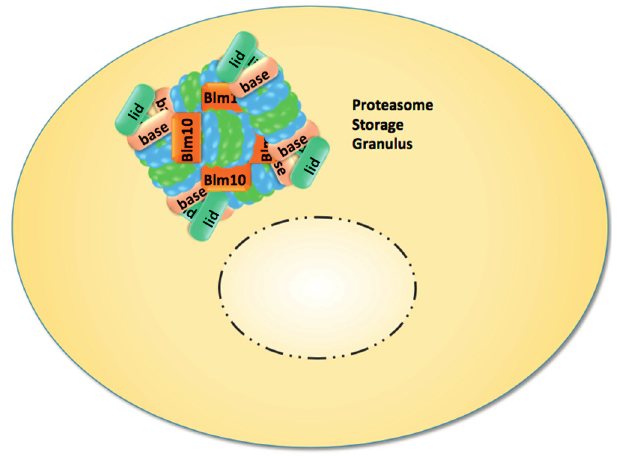
Figure 1. In quiescent yeast cells nuclear proteasomes are depleted and CP, RP, and Blm10-associated CP are sequestered into reversible and motile granules, which accumulate in the nuclear periphery and migrate through the